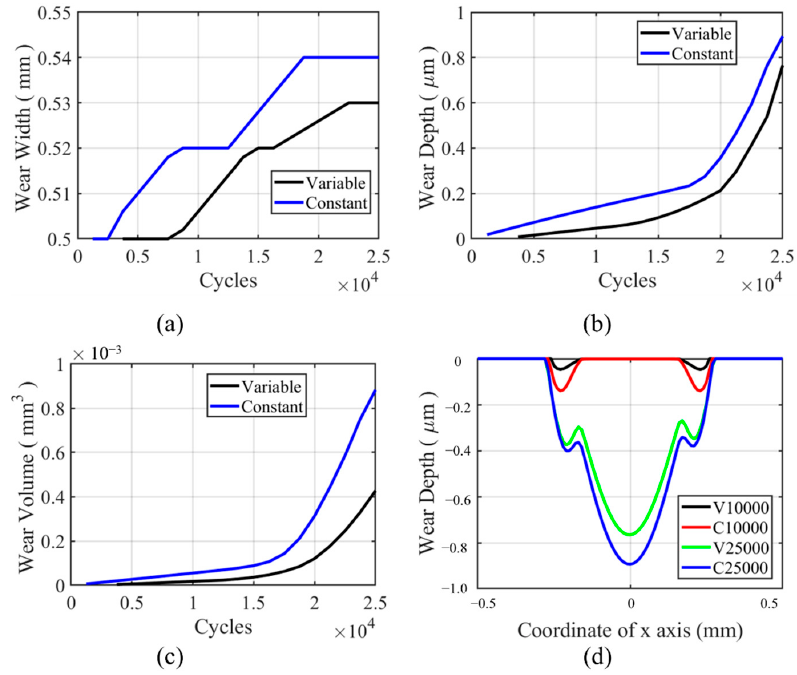
Figure 22. History and profile of wear characteristics for the flat specimen in the partial slip re- gime for both CWCM and VWCM: ( a – c ) are the history of wear characteristics, and ( d ) is the wear profiles after 10,000th and 25,000th cycle.